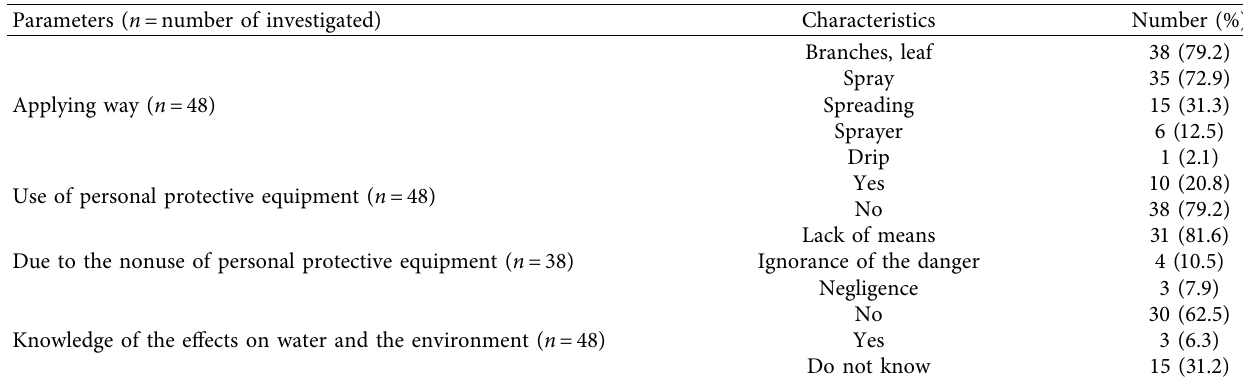
Table 5: Means of implementation and protection of pesticides and knowledge of risks by market